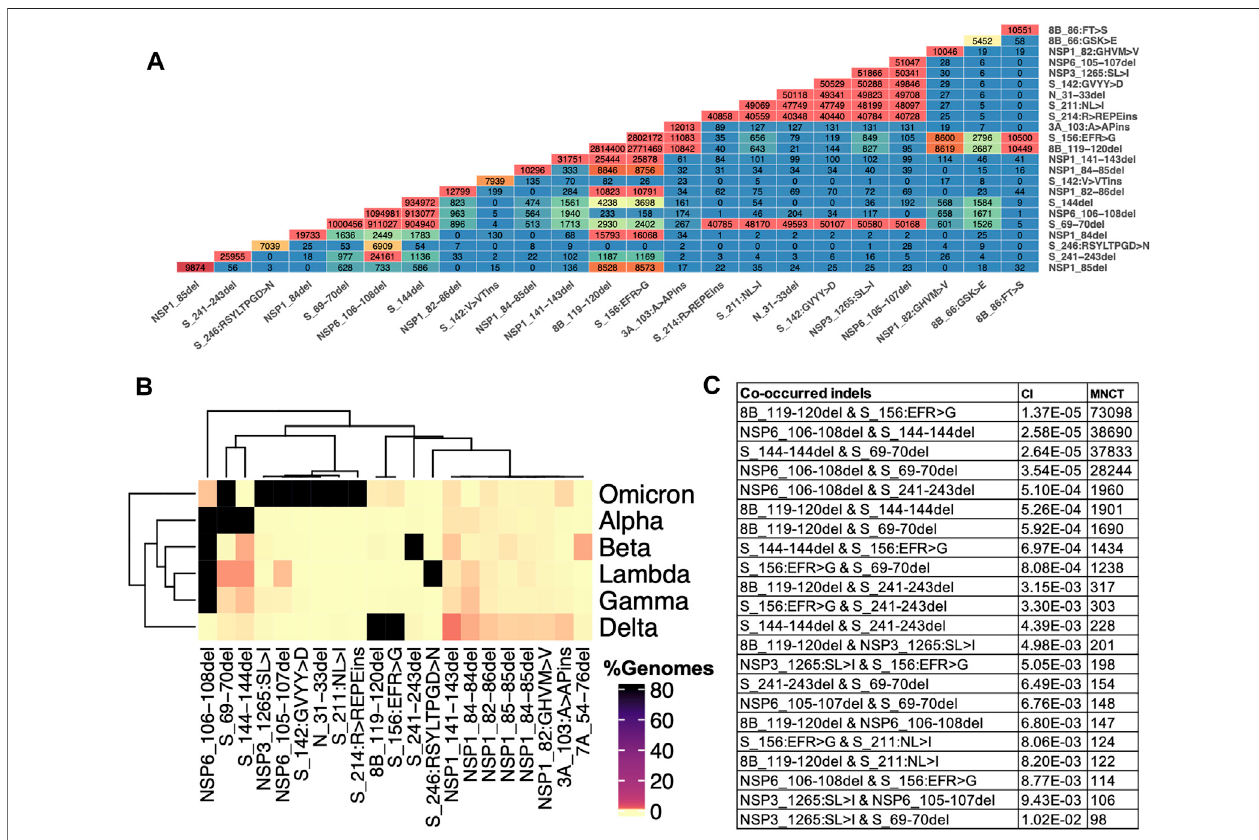
FIGURE 6 | Indels and their co-occurrence in SARS-CoV-2. (A) Co-occurrence of top frequent indels (B) Co-occurrence of top indels in VOCs. Data for these heatmaps is provided in Supplementary Table 2 which includes additional combinations ofindels in lineages harboring them (C) Independentco-occurrence of indels determined based on minimum number of changes on tree (MNCT) and consistency index (CI) calculated using HomoplasyFinder based on GISAID global tree (4,701,022 SARS-CoV-2 genomes as of January 7th,